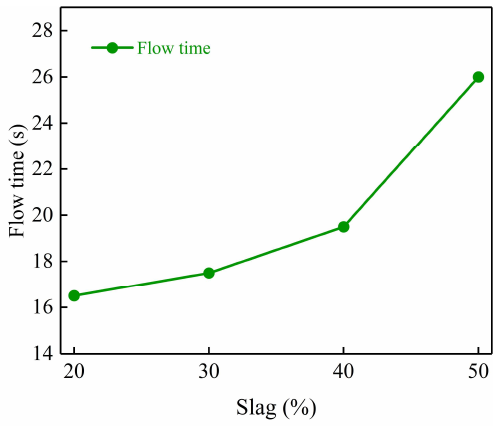
Figure 17. Effect of different mineral powder blending on flow rate .